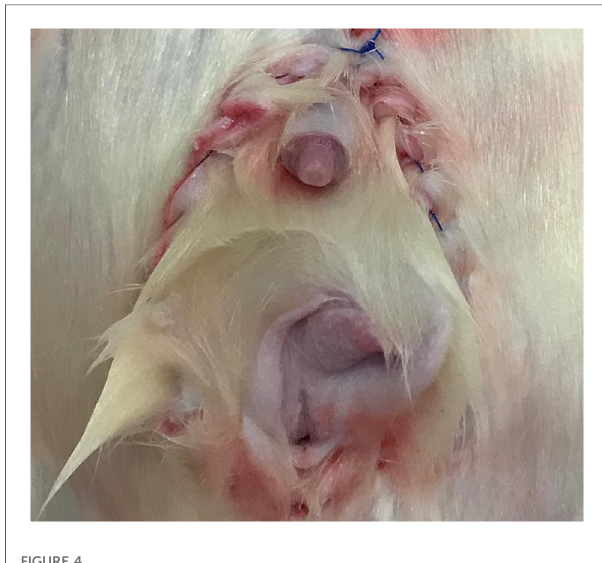
FIGURE 4 The fi nal appearance of pelvic fl oor transplantation in a male